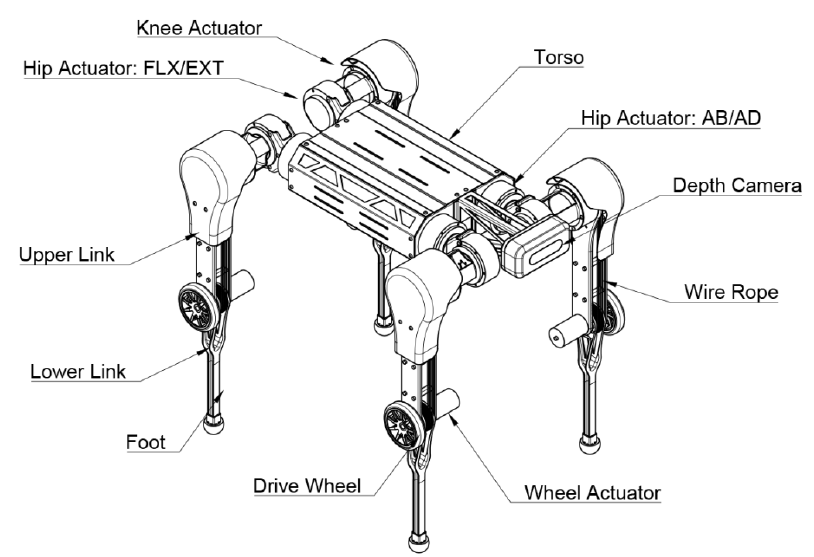
Figure 2. The designed structure of the robot platform.